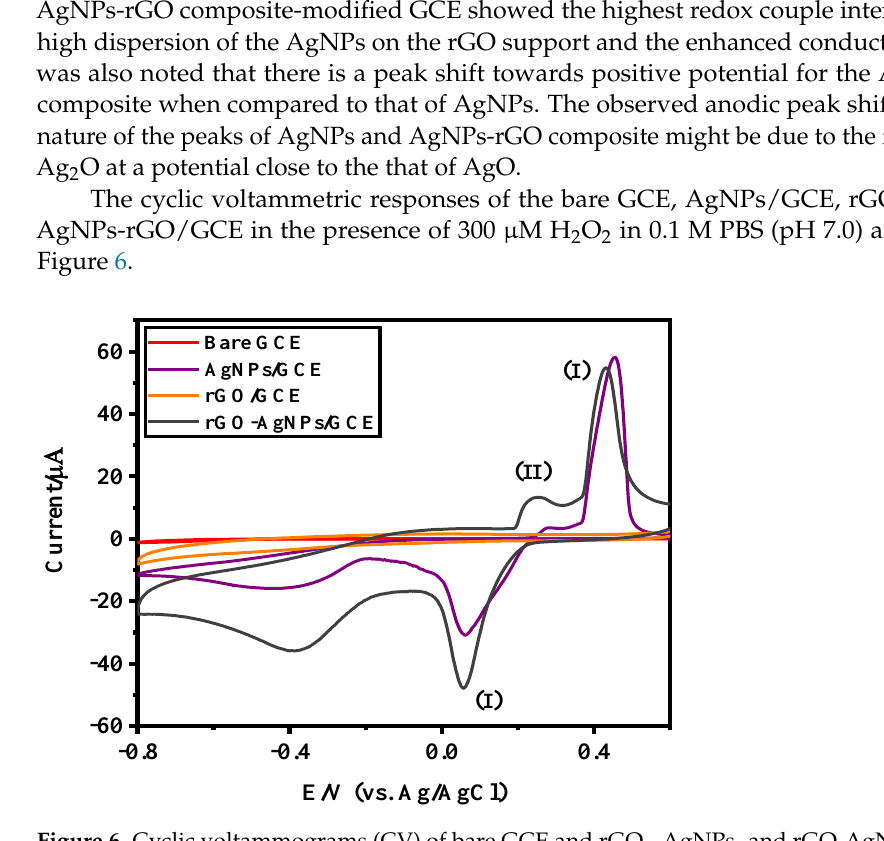
Figure 6. Cyclic voltammograms (CV) of bare GCE and rGO-, AgNPs- and rGO-AgNPs-modified GCEs in the presence of 300 µM H 2 O 2 in 0.1 M phosphate buffer solution (PBS) (pH 7.0) and (I) denotes the reaction of formation of AgO and (II) denotes the formation of Ag 2 O during the potential scan.